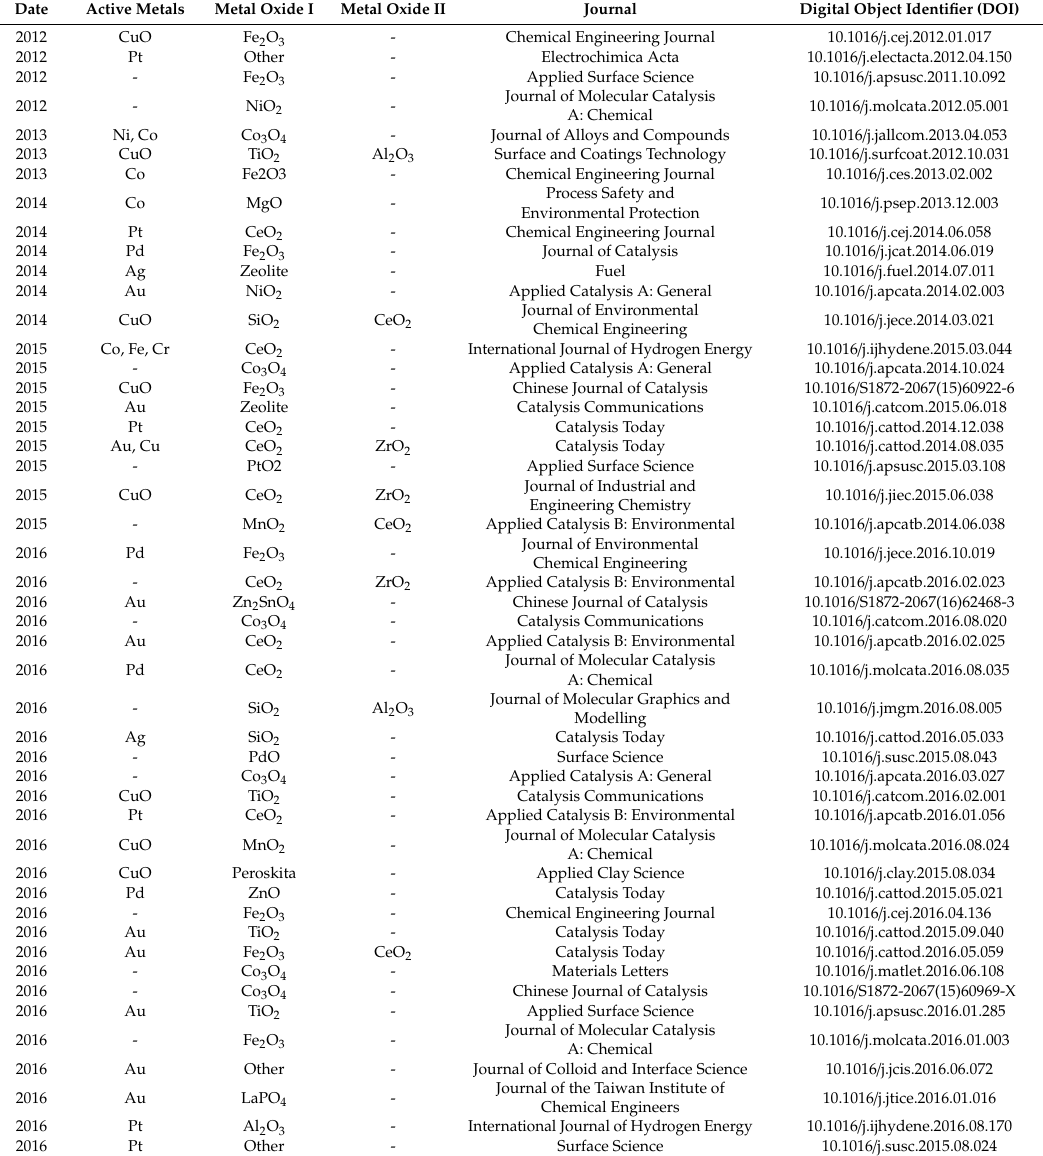
Table A2. Reviewed articles for the selection of supports evaluated in the CO